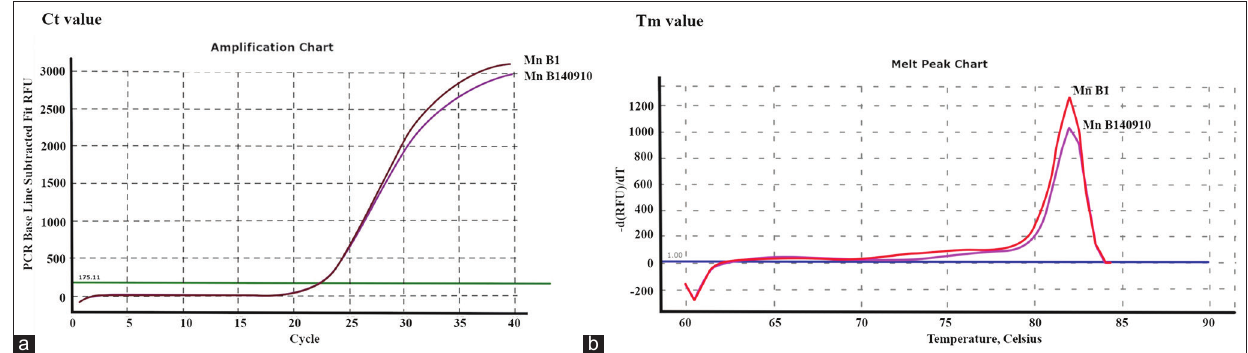
Figure-1: Characteristics of novel simian endogenous retroviruses based on real-time polymerase chain reaction of SYBR Green were shown: (a) Curve of cycle threshold value <24.0; (b) curve of temperature value at temperature range